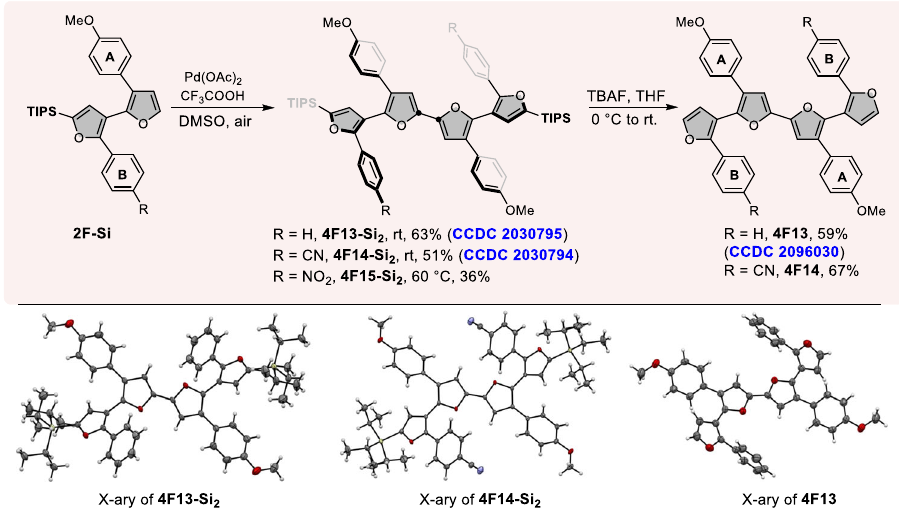
Fig. 5 Bottom-up synthesis of tetrafuran through oxidative homocoupling. Oxidative homocoupling reactions were run with 0.25 mmol of 2F-Si (1.0 eq.), Pd(OAc) 2 (1.0 eq.), and CF 3 COOH (1.0 eq.) in 1.5 mL DMSO at r.t., isolated yields. Desilication reactions were run with 4F-Si 2 (0.2 mmol) and